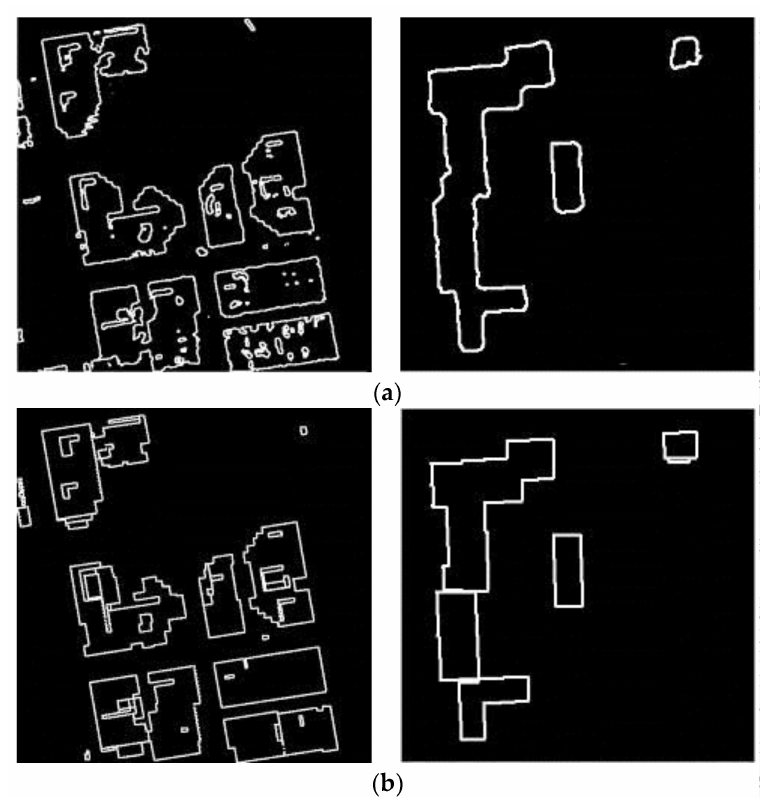
Figure 14. The binary image of the outlines ( a ) outline results by the segmentation method; ( b ) outline results by our method.